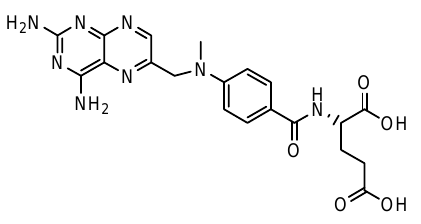
Figure 1. Chemical structure of methotrexate